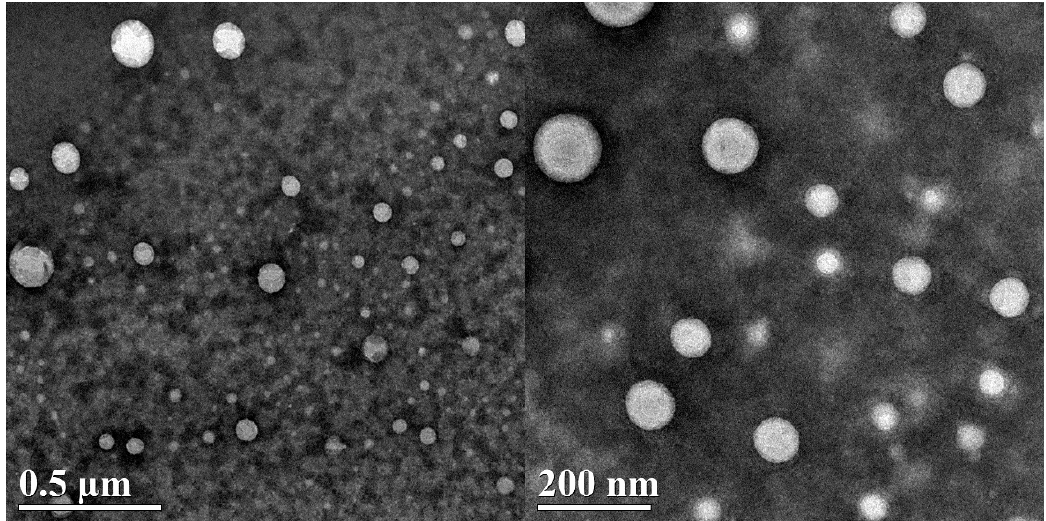
Figure 3. TEM images of the low gloss aqueous acrylic resin with crosslinker AMA content 0.2 wt % at different magnifications.